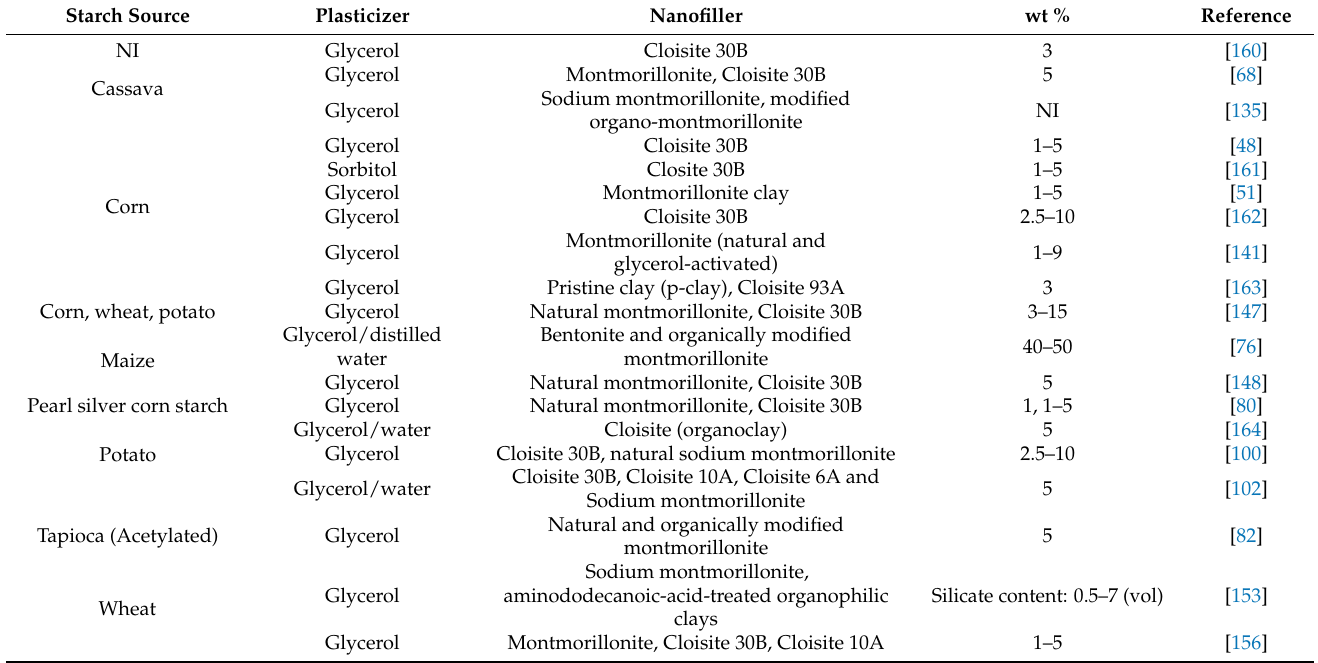
Table 4. Plasticizers and organically modified montmorillonite as nanofiller (including their wt %) in most used TPS sources. Starch Source